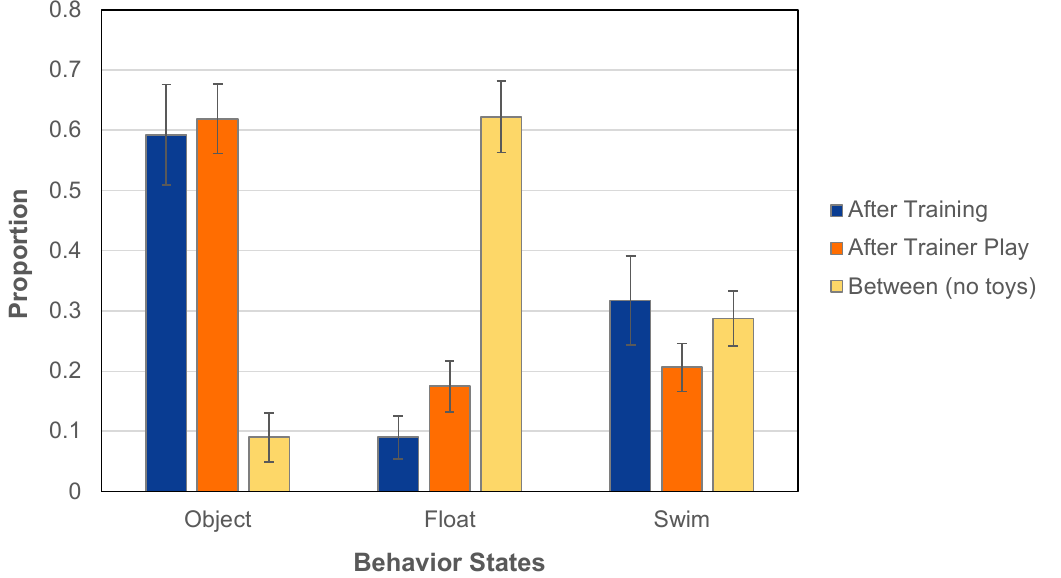
Figure 3. Mean proportion of intervals (+/ − SEM) spent in each behavioral category during each con ‐ dition, Phase 1.